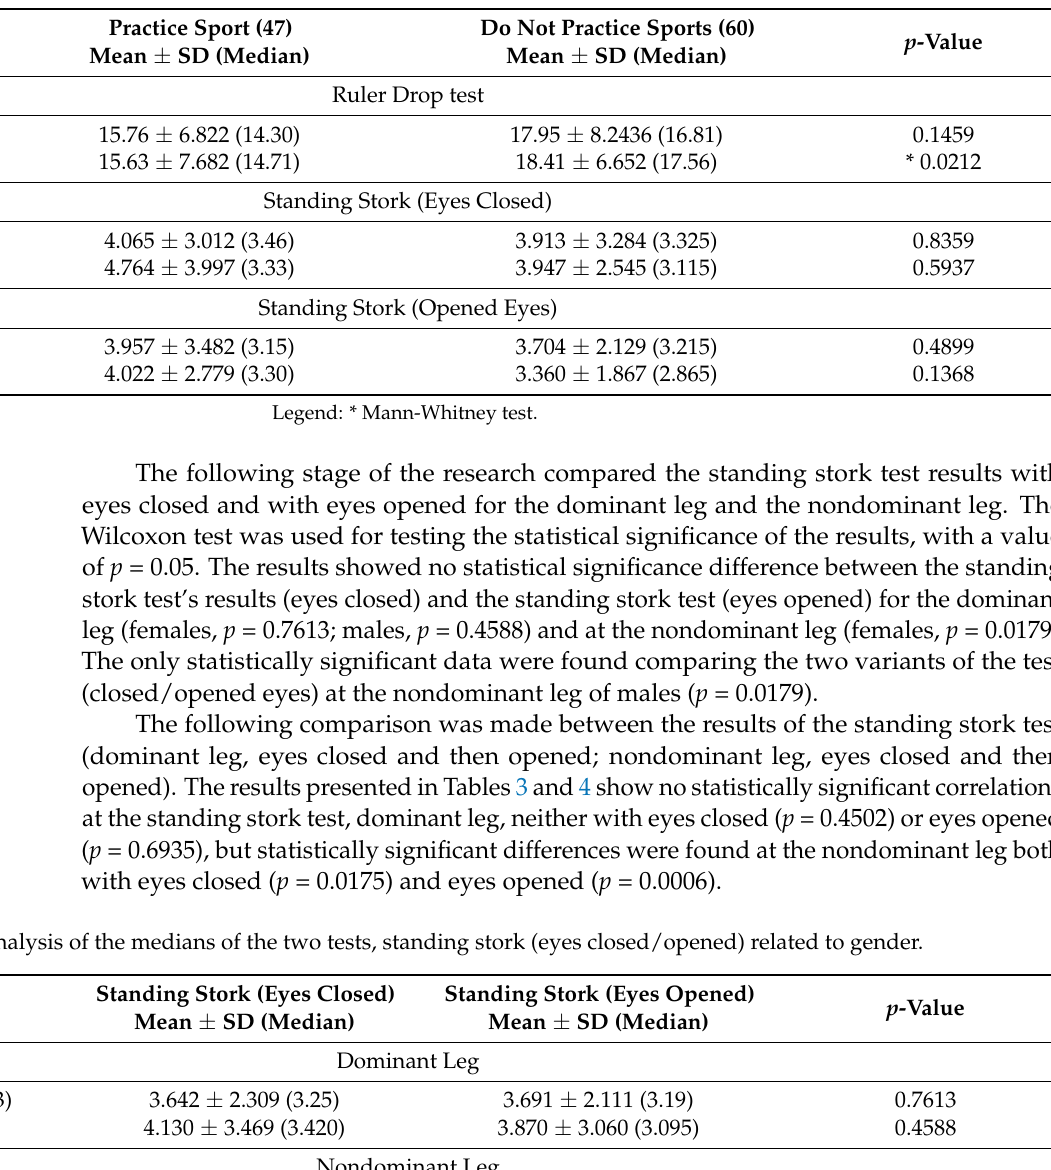
Table 2. Statistical comparison between children who practice sports and those who do not practice.